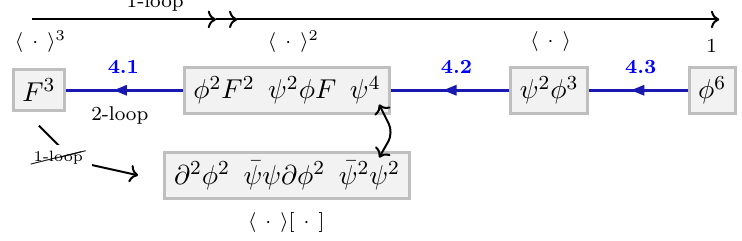
Figure 1 . One-loop RG mixing can only occur from operators renormalising operators in boxes to the right or in the same box, with the only exception of the four-fermion of type h (cid:1) i 2 and type h (cid:1) i [ (cid:1) ] that do mix. One-loop transitions from h (cid:1) i 3 -type operators to h (cid:1) i [ (cid:1) ] is forbidden by helicity selection rules. These patterns are summarised by the black arrows in the (cid:12)gure. With blue arrows we indicate the two-loop anomalous dimensions that are computed in the sections indicated on